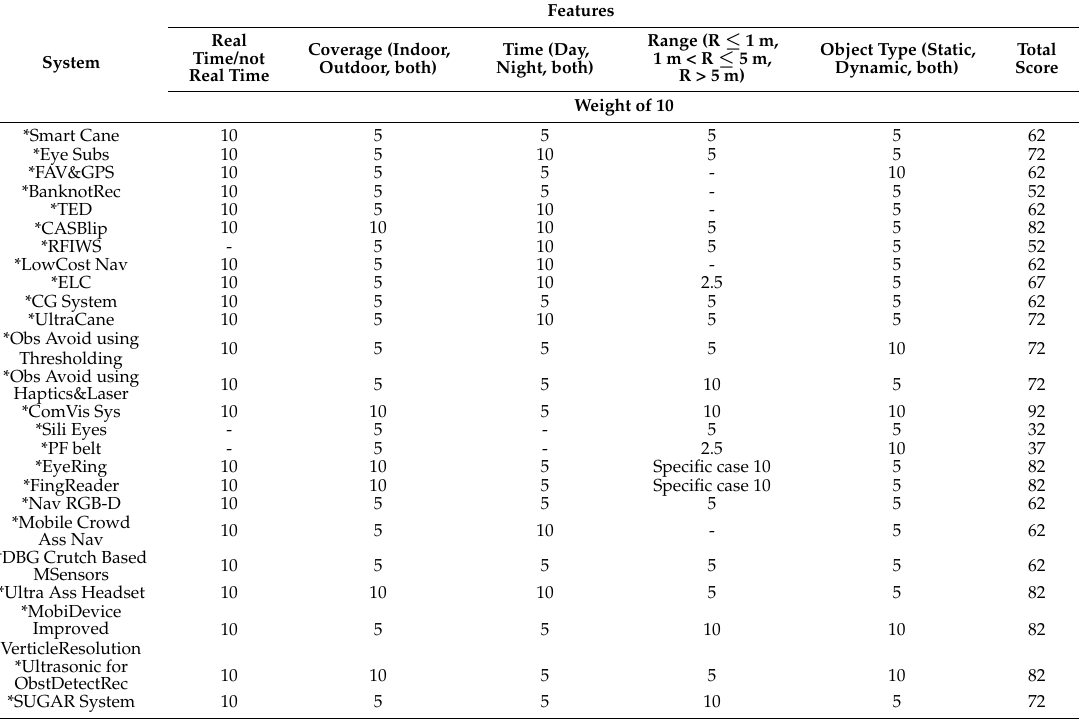
Table 2. Score and evaluation for each